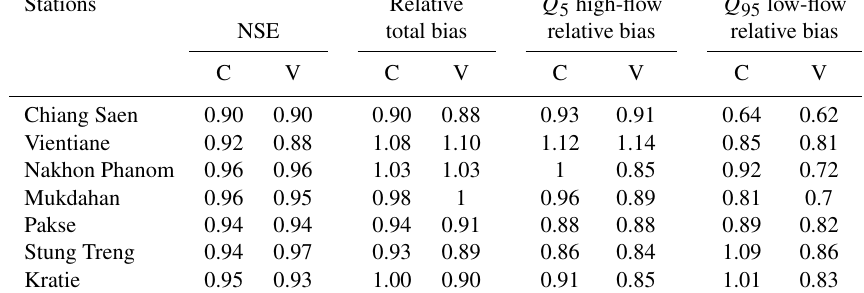
Table 2. Model performance indices calculated from daily time series for calibration (C) and validation (V) periods. See station locations in Fig. 1.